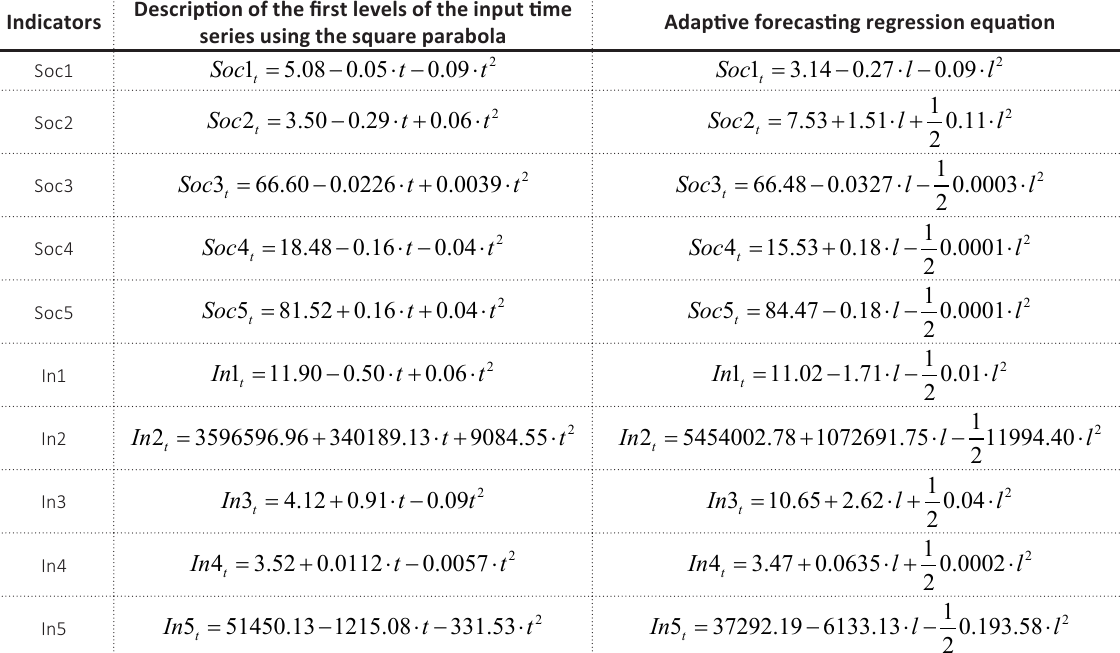
Table 1. Interim calculations of the trend equation of adaptive forecasting in terms of socio-economic conditions and infrastructure for 1999–2018